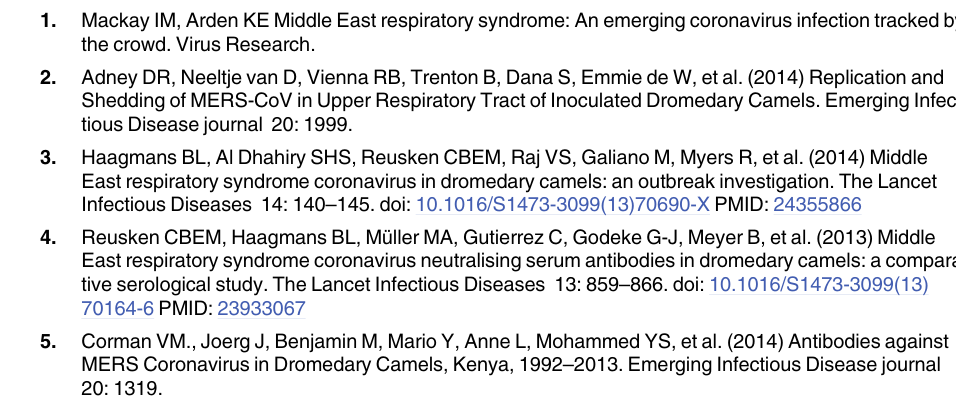
S1 Fig. PCR amplification of MERS-CoV (strain EMC/2012) using primers tested as individual reactions (A) and in two multiplexed reactions (B). (A) Primer sets are listed above each gel product. (B). Multiplex products include bands of expected size, as well as smaller bands and primer dimers. S1 Table. MERS primer sequences and positions. S2 Table. Frequency of consensus and iSNV nts, and position coverage based on ORP data (non primer regions). The iSNV data is distributed between two spreadsheets, the first, S2A Table, shows all iSNVs that detected outside of the primer regions, and the second, S3 Table, shows iSNVs occurring in primer regions. iSNVs detected within primer sites were examined separately to consider the potential for un-trimmed primer errors to remain in reads mapped to the reference genome. In total this table consists of approx. 2000 rows of iSNV data and is available on request as an Excel spreadsheet. S3 Table. Frequency of consensus and iSNV nts, and position coverage based on ORP data (primer